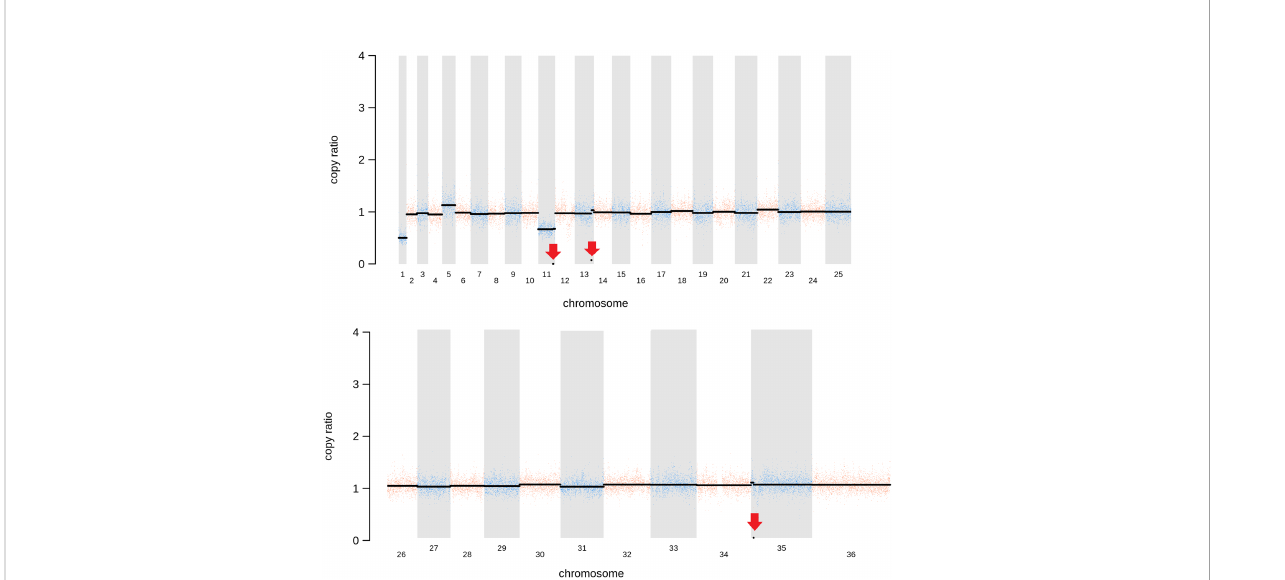
FIGURE 2 Copy Number Variations (CNVs) in Lmj LCB2-/-. Diagram showing the copy number ratio in chromosomes 01, 11, 13 and 35 (decrease) and 05 (increase) with no change for most chromosomes. The copy ratio median (thick black lines) is shown in log2 ratio (y-axis) for all the chromosomes (x-axis). As detailed in Table 4, the alterations affected 100% and 97.5% of chromosomes 01 and 05 respectively. The changes observed in the other chromosomes (11, 13 and 35) were more heterogenous, therefore the position of the gene(s) deleted within each chromosome is highlighted (red arrows). Copy ratio alterations were detected comparing the mutant line ( Lmj LCB2-/-) with the corresponding copy number of the parent used as the base line. Plots of denoised and segmented copy-ratios were generated using R. See S4 and S5